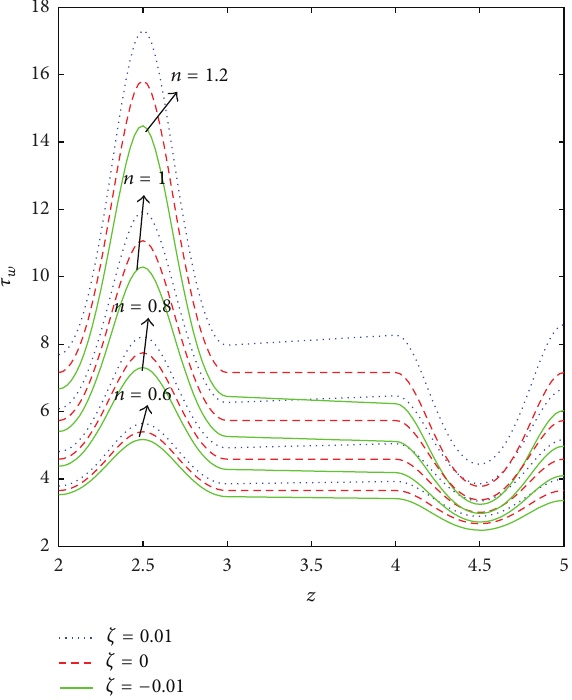
Figure 5: Axial variation of wall shear stress ( 𝜏 𝑤 ) for different values of power law index ( 𝑛 ) taking 𝑘 = 1.4 , 𝛿 = 0.2 , and 𝜏 𝑦 = 0.1